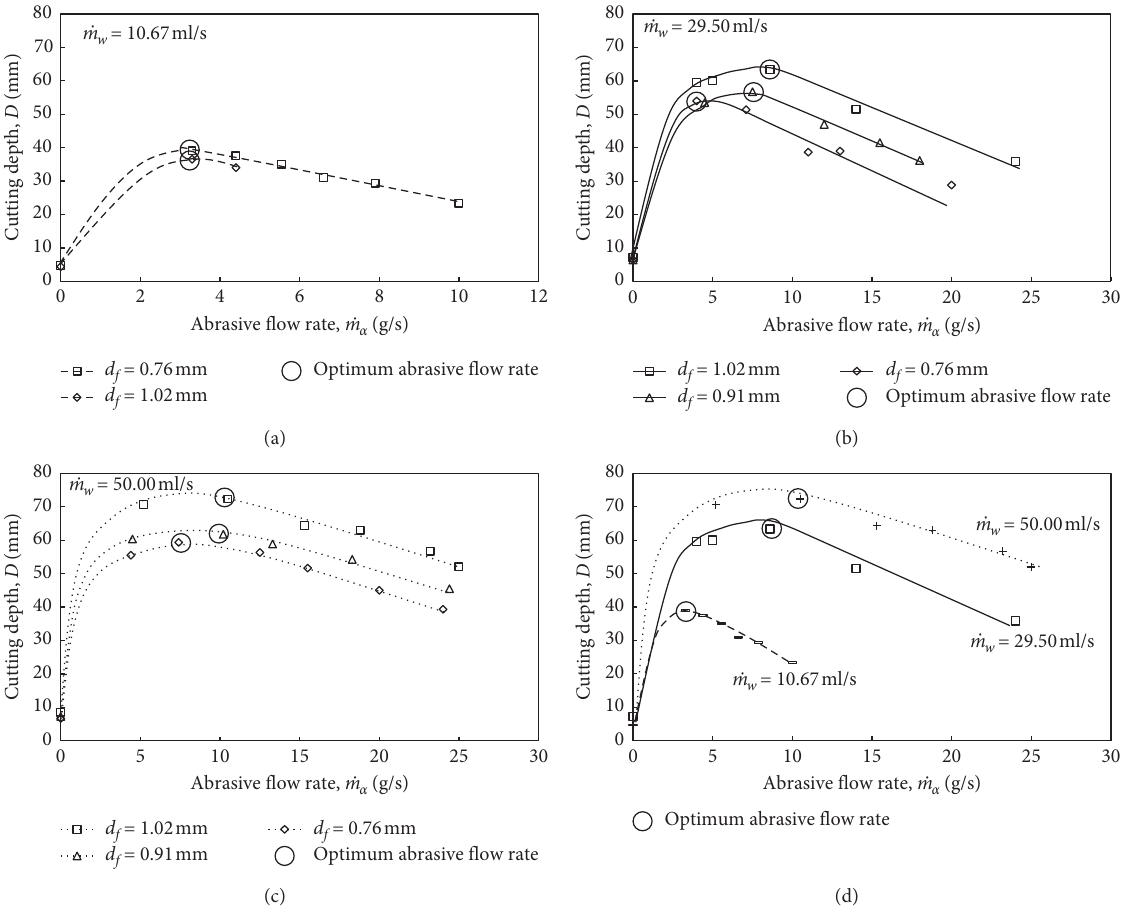
Figure 7: Effects of the focus diameter on the cutting depth at a constant l and (c) 50.00ml/s and (d) the total water flow rate with d f � 1 . 02